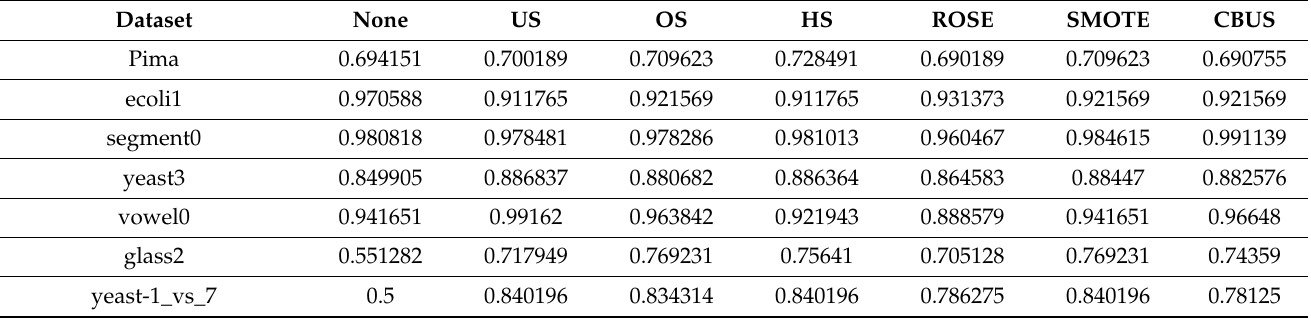
Table 4. Performance of DBT for